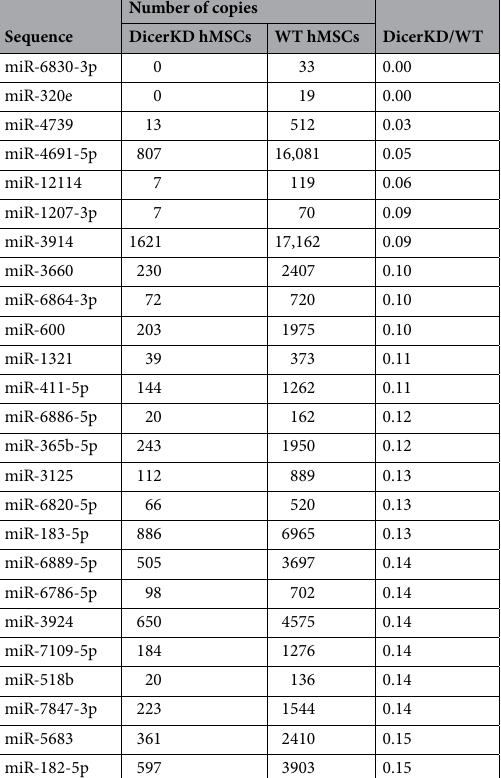
Table 2. Top 25 downregulated miRNAs in DicerKD hMSCs compared to WT